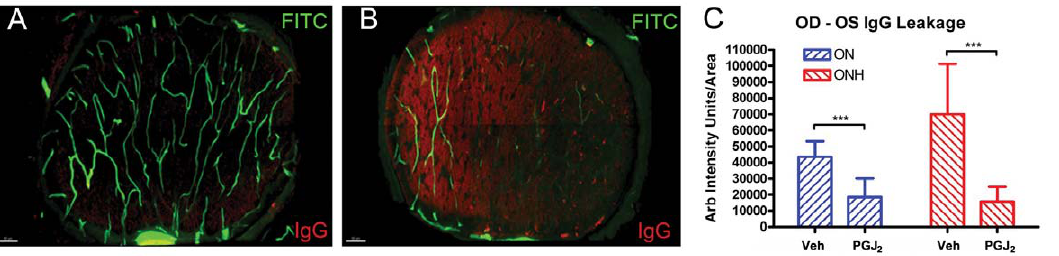
Figure 4. BBB breakdown measured by serum IgG leakage in FITC-BSA filled ON. Animals were perfused with FITC-BSA (green). ONs were fixed and reacted with anti-rat IgG (red), as a marker of serum leakage. Two ON regions were evaluated: the optic nerve head (ONH), which is the region of the primary injury and ON , 2 mm posterior (ON). A. Naı¨ve eye. There is minimal IgG signal in the ON cross-section. Vascular perfusion is intact, as evaluated by FITC-BSA signal. B. One day post-induction. There is reduced FITC-BSA signal, and increased IgG signal. C. Quantitative analysis of intraneural IgG levels 1 d post-rAION. There is increased IgG signal in the primary lesion site (the optic nerve head, ONH) and more posteriorly, in the ON, in animals treated with vehicle, compared with PGJ2-treated animals. This difference is significant (***; Mann-Whitney U-test, p , 0.05). Scale bars: 50 microns.